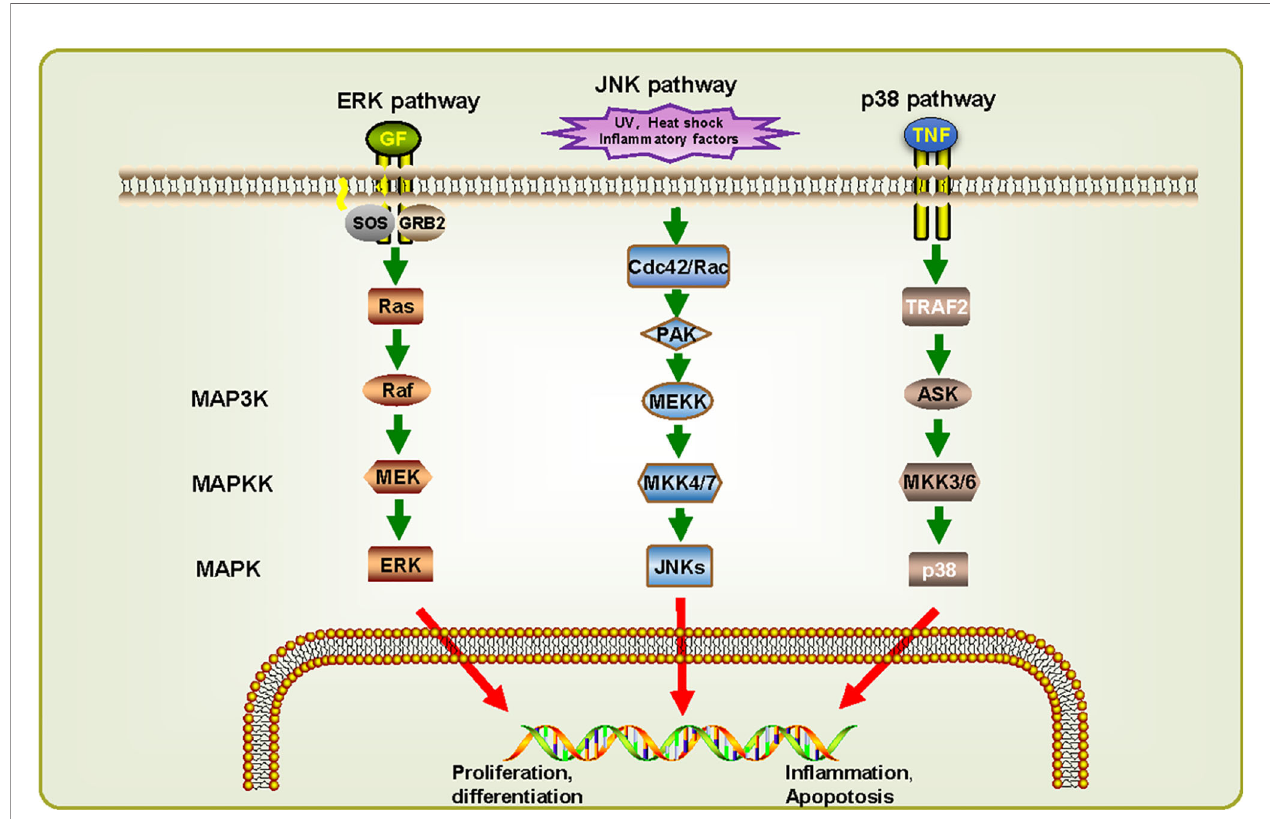
FIGURE 4 | MAPK signaling cascades in Schistosoma japonicum . Three signaling pathways were predicted: ERK pathway, JNK pathway, and p38 pathway. They can be classi fi ed into three kinase modules including a MAPK, a MAPK kinase (MAP2K/MKK) and a MAPK kinase kinase (MAP3K/MKKK). The proteins shown in white have not (yet) been identi fi ed in S. japonicum . UVw, heat shock, in fl ammatory factors, and cellular stresses can advance the activation of different MAPK pathways, which in turn phosphorylate downstream